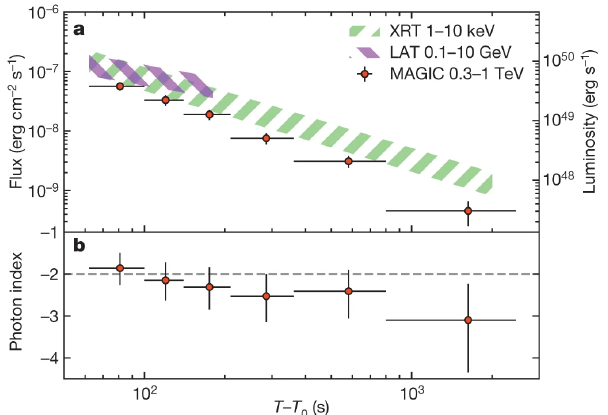
Figure 18. GRB190114C. Upper panel: MAGIC light-curve (red circles), compared with the XRT (green band) and LAT (red band) emission. Bottom panel: temporal evolution of the intrinsic spectral photon index in the MAGIC data analysis time bins. From [3].